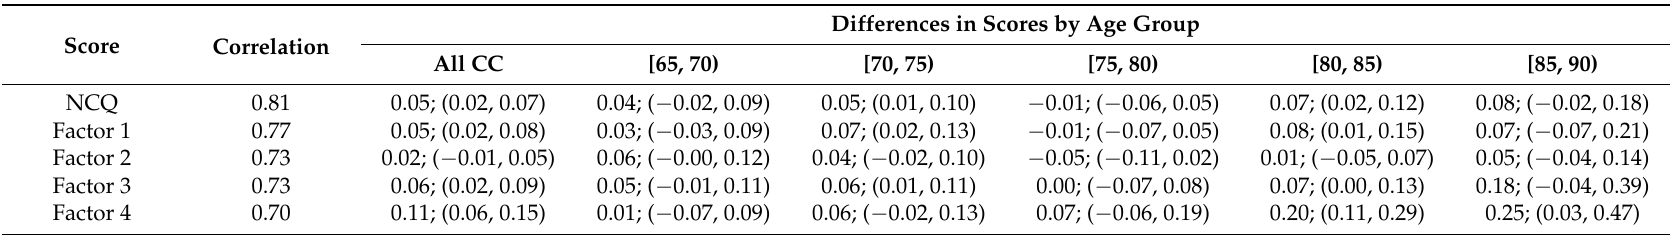
Table 6. Correlation and differences in scores (95% confidence intervals) from the 1st to the 2nd administrations for the CC sample ( N =